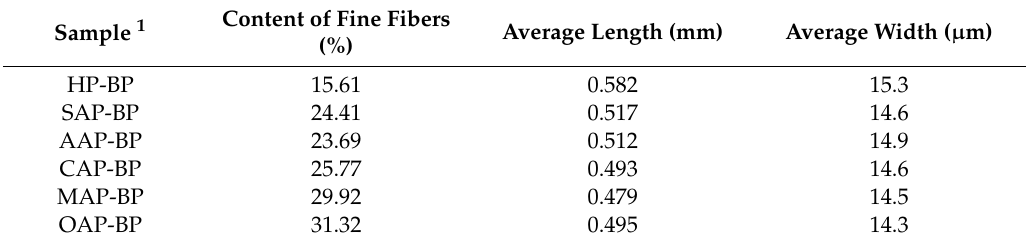
Table 6. Dissolved pulp fiber quality